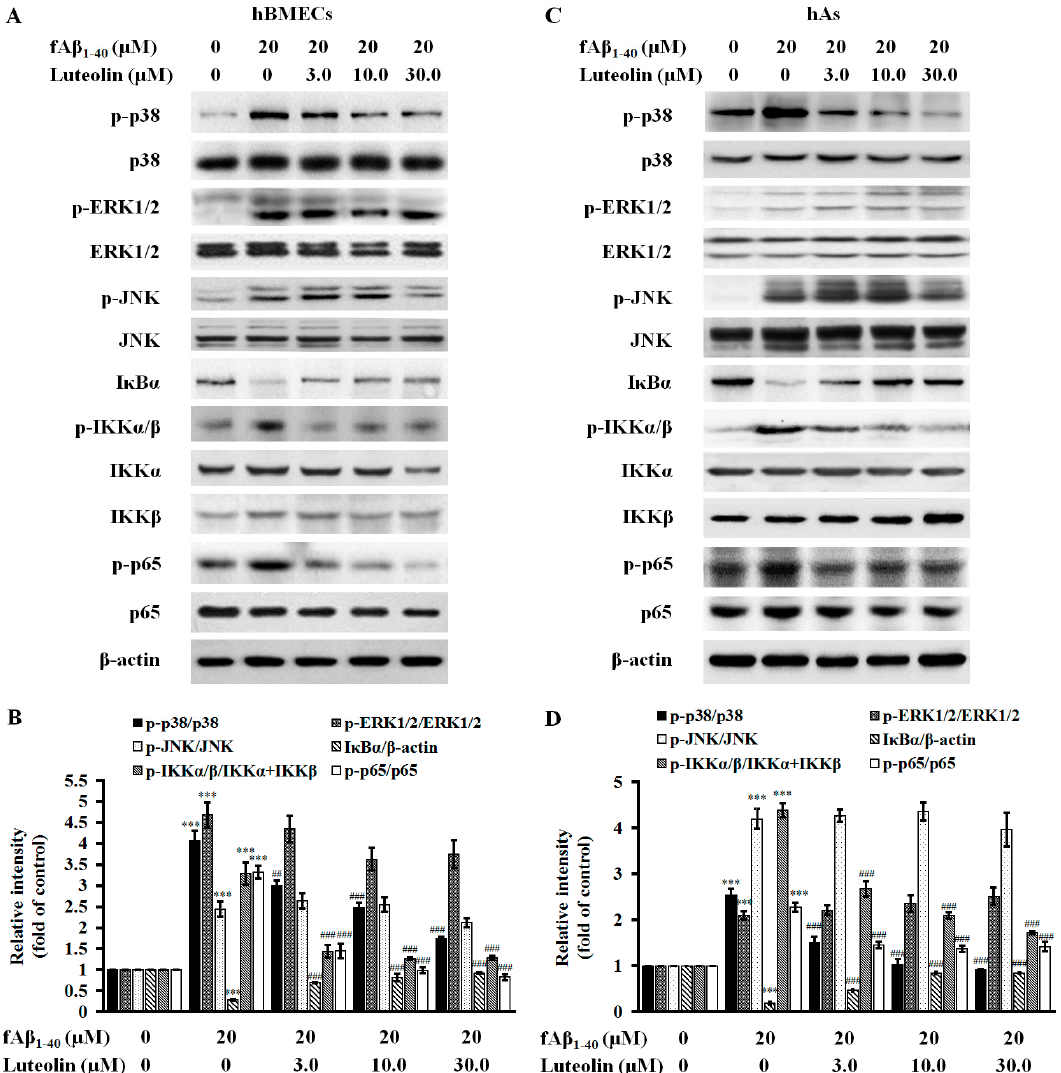
Figure 5. Luteolin suppresses mitogen-activated protein kinases (MAPKs) and nuclear factor κ B (NF- κ B) signaling pathways against fA β 1–40 -induced toxicity. Representative immunoblots illustrate the expression of phosphorylated p38 (phosphor-p38), p38, phosphorylated extracellular signal-regulated kinase 1/2 (ERK1/2) (phosphor-ERK1/2), ERK1/2, phosphorylated c-Jun N-terminal kinase (phosphor-JNK), JNK, phosphorylated inhibitory κ B kinase α / β (phosphor-IKK α / β ), IKK α , IKK β , inhibitory κ B α (I κ B α ), phosphor-p65, and p65 in hBMECs ( A ) and hAs ( C ) extracts of the co-culture after exposure to fA β 1–40 for 72 h. Quantitative analysis of the above-mentioned proteins by hBMECs ( B ) and hAs ( D ) was demonstrated. Data are expressed as the mean ± SEM; n = 3; *** p < 0.001 vs. control; ## p < 0.01; ### p < 0.001 vs. fA β 1–40 .